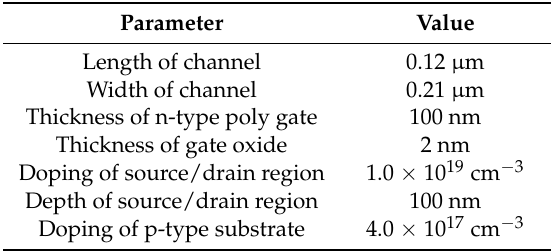
Table 1. The parameters that were used for the device’s